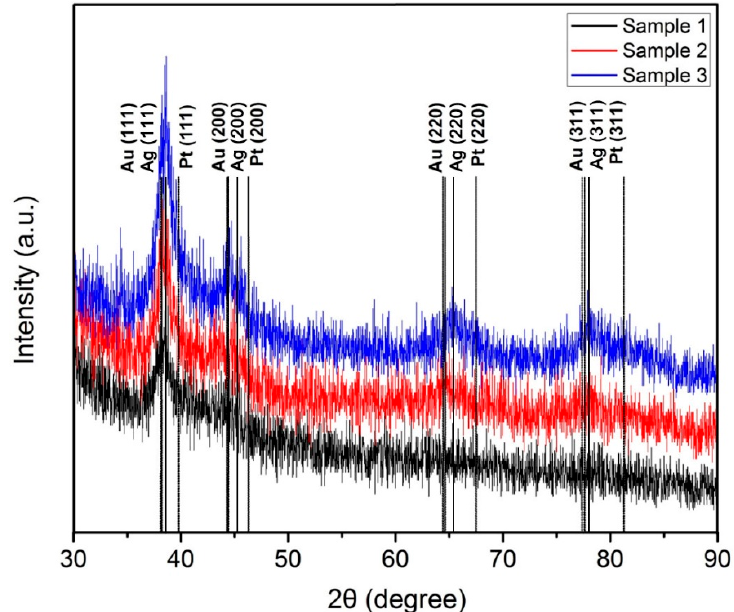
Figure 6. XRD patterns of Pt nanocluster-anchored hollow Ag-Au nanostructures with injected molar ratios of Pt / Au at 1 (black line), 2 (red line) and 3 (blue line).